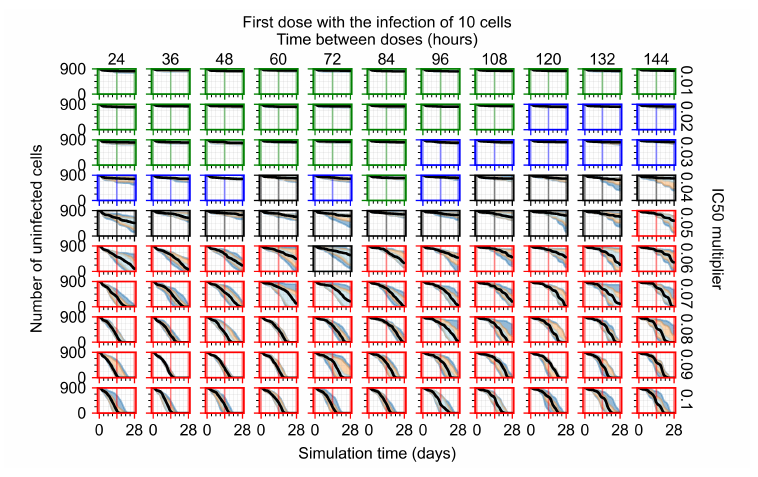
Figure A75. Uninfected population.